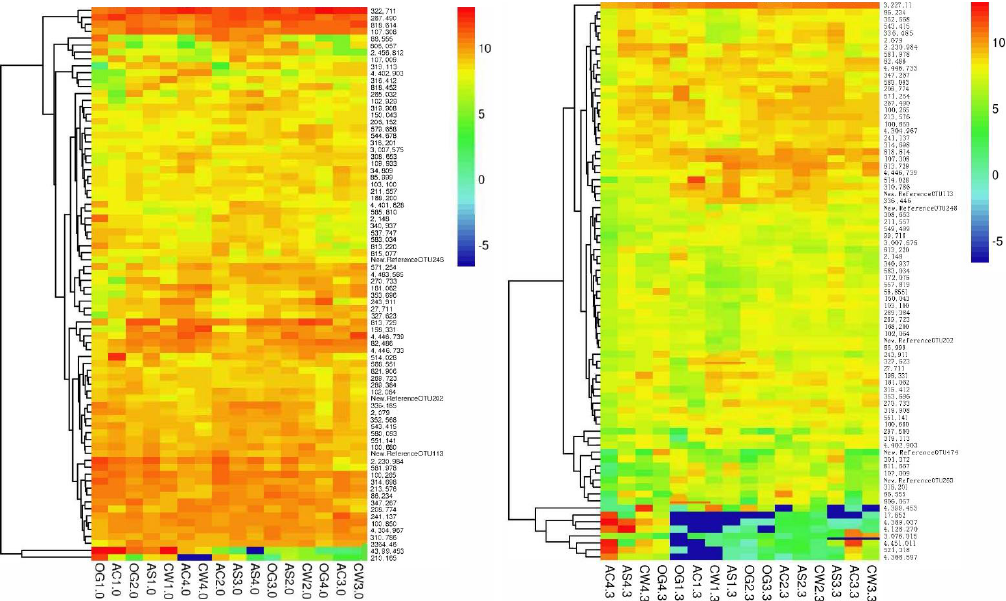
Figure 2. The heat map of different ruminal microbes on genus. (Select the OTU drawing with the top 80 reads; each column represents a sample, each row represents an OTU and its corresponding species information, color depth represents the number of reads contained in the OTU, red represents high, blue represents low).